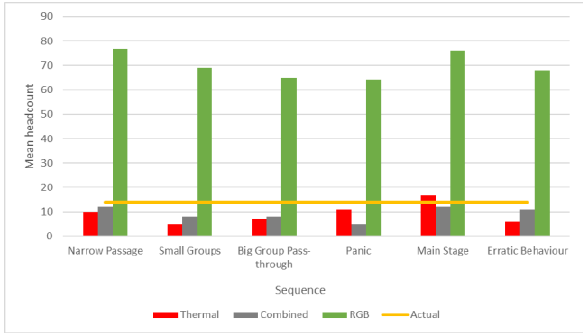
Figure 11. Diagram of the mean headcount for every crowd scenario and every detection method with the actual real world headcount.